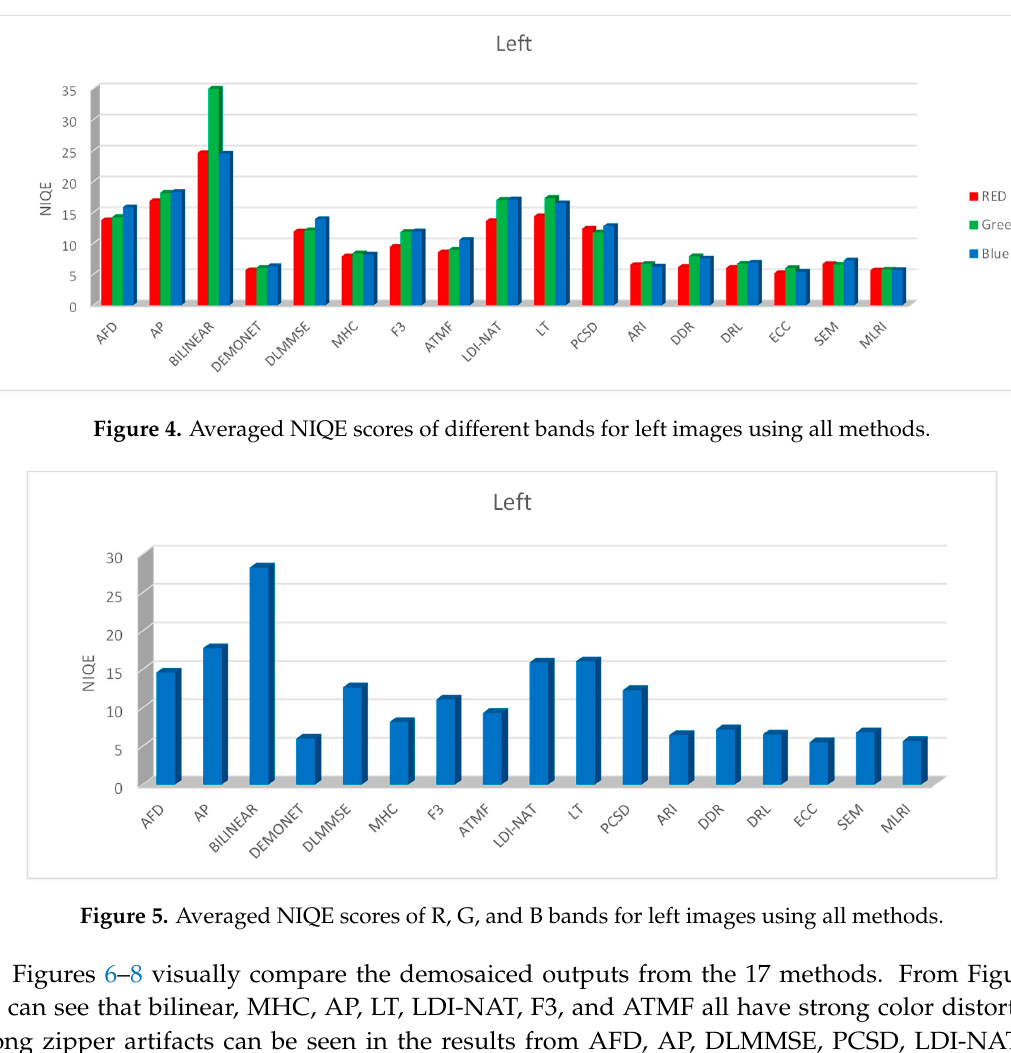
Figure 6. Subjective comparison of demosaiced images of different algorithms for left Mastcam image 1.